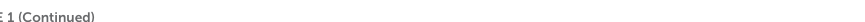
FIGURE1(Continued) of the macro–microelectrodes (M1–M4: macroelectrode contacts; µ 1– µ 8: microelectrodes). All the geometrical features of the electrodes are expressed in millimeters. Macroelectrode recordings (C, F, I, L) are shown in a bipolar montage. Three LFP patterns were recorded: periodic discharge plus fast activity (PD + F), sporadic discharges plus fast activity (SD + F), and epileptic spikes (ES). These patterns were apparent on microelectrodes (LFP µ 1 and µ 2) and to a smaller degree also on macroelectrodes (M1–M2). LFP patterns were associated with MUA recorded on the